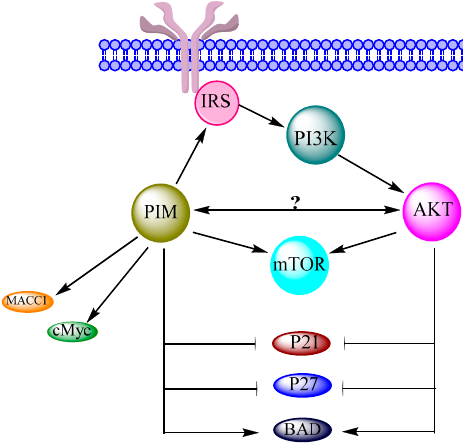
Figure 4. Possible interaction between PI3K/AKT/mTOR network and PIM in ovarian cancer [9,16]. Metastasis-associated in colon cancer-1 (MACC1).